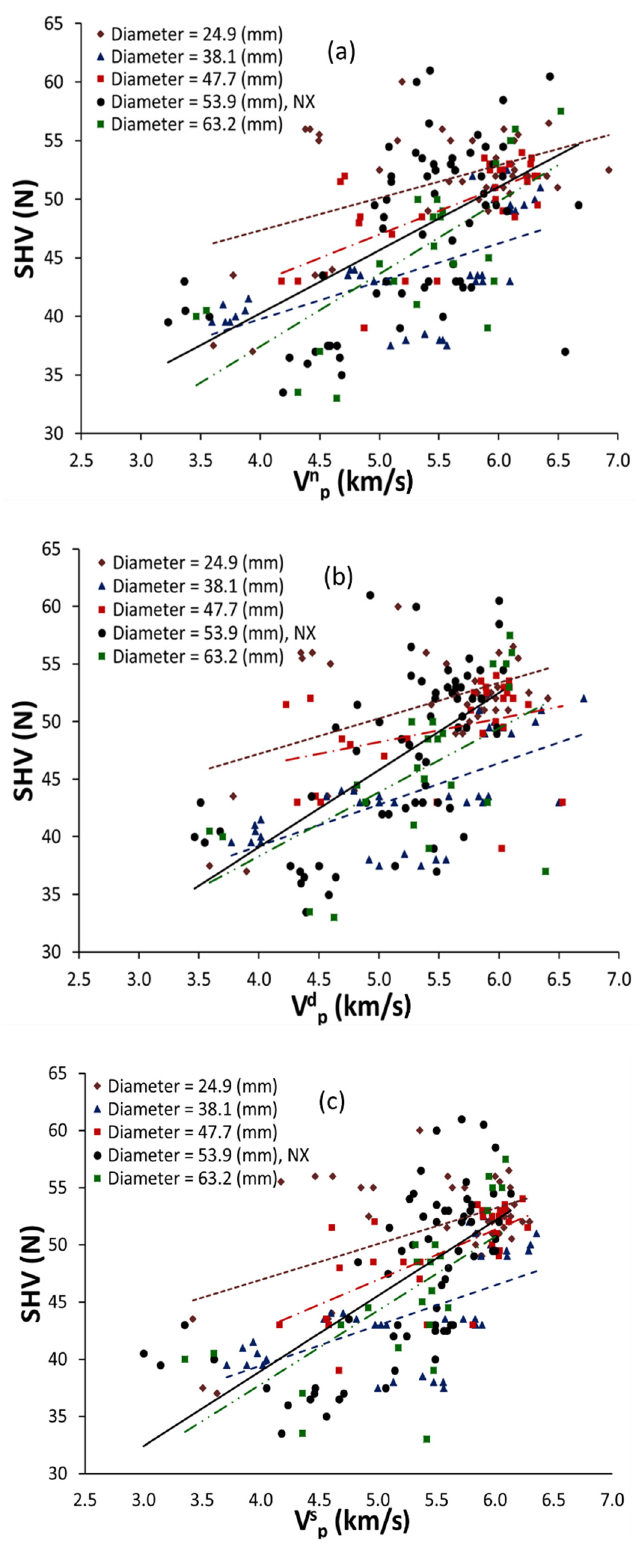
Figure 5. Variation in Schmidt hammer value (SHV). SHV plotted as a function ( a ) V np , ( b ) V dp , and ( c ) V sp for different sample diameters.